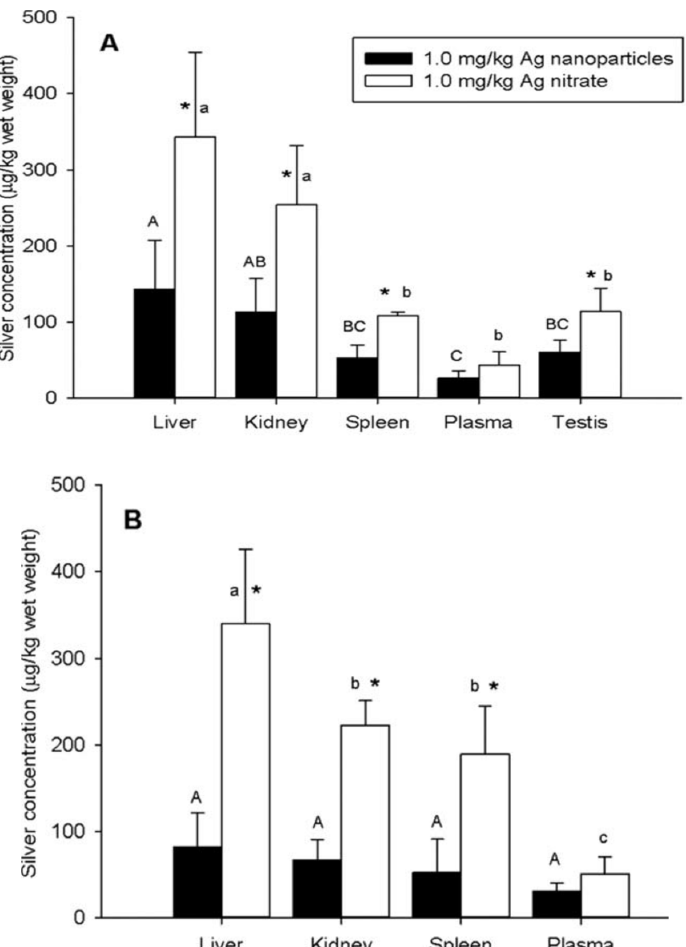
Figure 28. Silver concentrations in major organs and plasma of ( A ) male and ( B ) female rats. Values are presented as means ± SD, n = 5. The asterisk (*) indicates significant difference between AgNPs and AgNO 3 treatment groups at p < 0.05. Means with the same capital letters are not significantly different among AgNPs groups ( p < 0.05) and same small letter are not statistically different among AgNO 3 groups by the Tukey test ( p < 0.05). Reproduced from [238] with permission of Wiley.